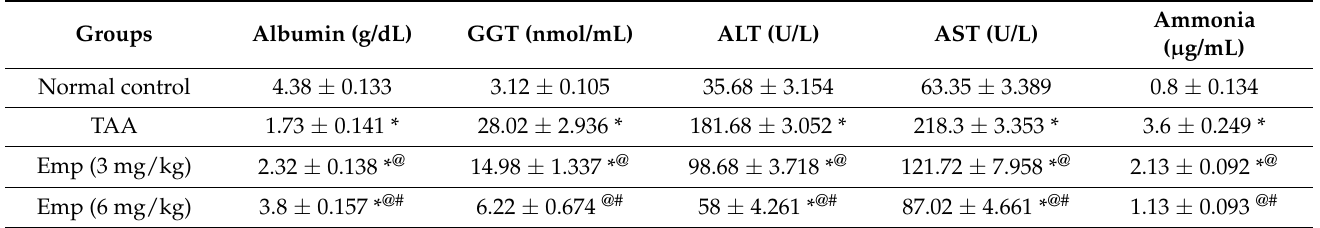
Table 1. Effect of empagliflozin on serum hepatic function in thioacetamide-intoxicated rats.